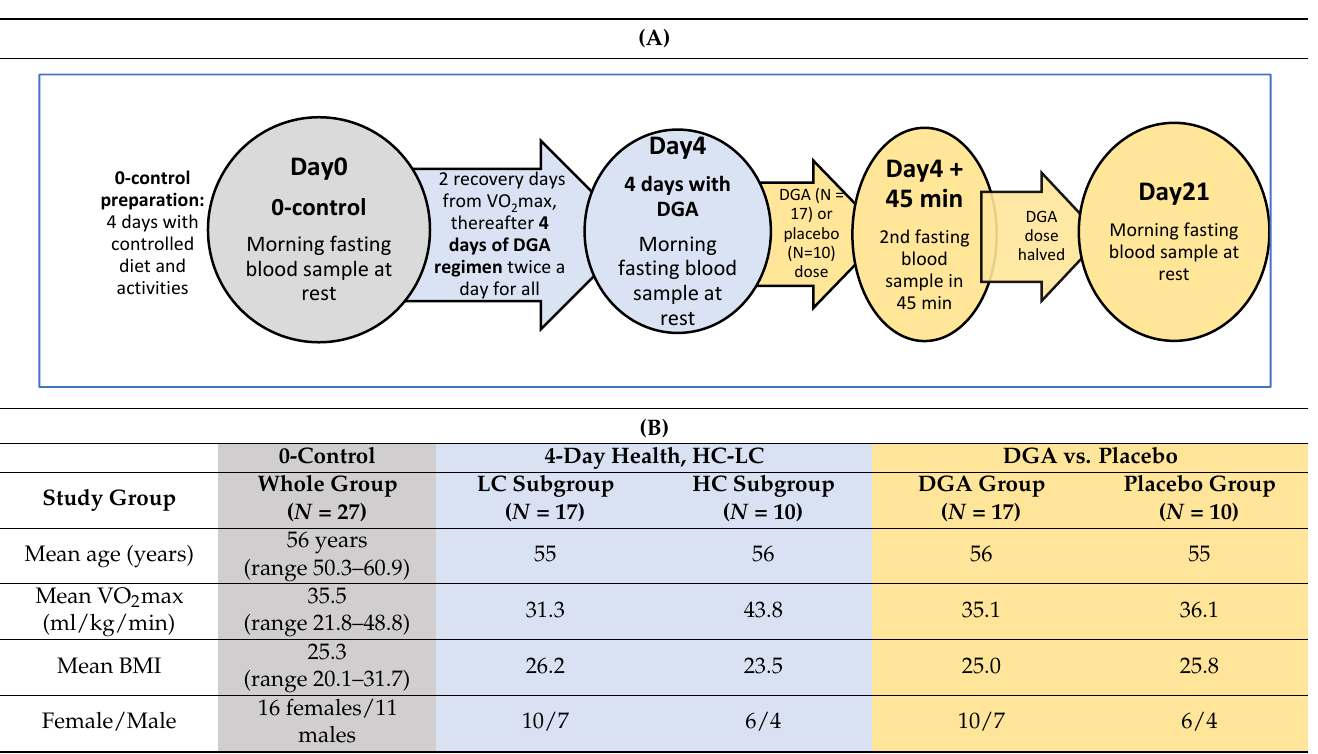
Table 1. ( A ) Study phases and timings, ( B ) characteristics of the study group and analysed subgroups modified from our earlier publication [27].